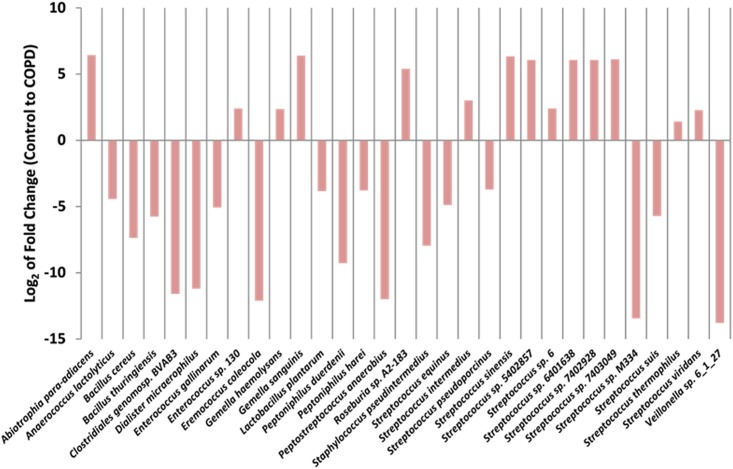
Significant changes in species abundance from Control to COPD.Using MetaboAnalyst 2.0, t-tests and fold-differences were calculated from normalised percentages of reads, with only those with a P value of < 0.05 charted. Significant differences in species abundances show both higher and lower levels in COPD samples, compared to Controls. Analysis shows that the Streptococcus genus is particularly dynamic.